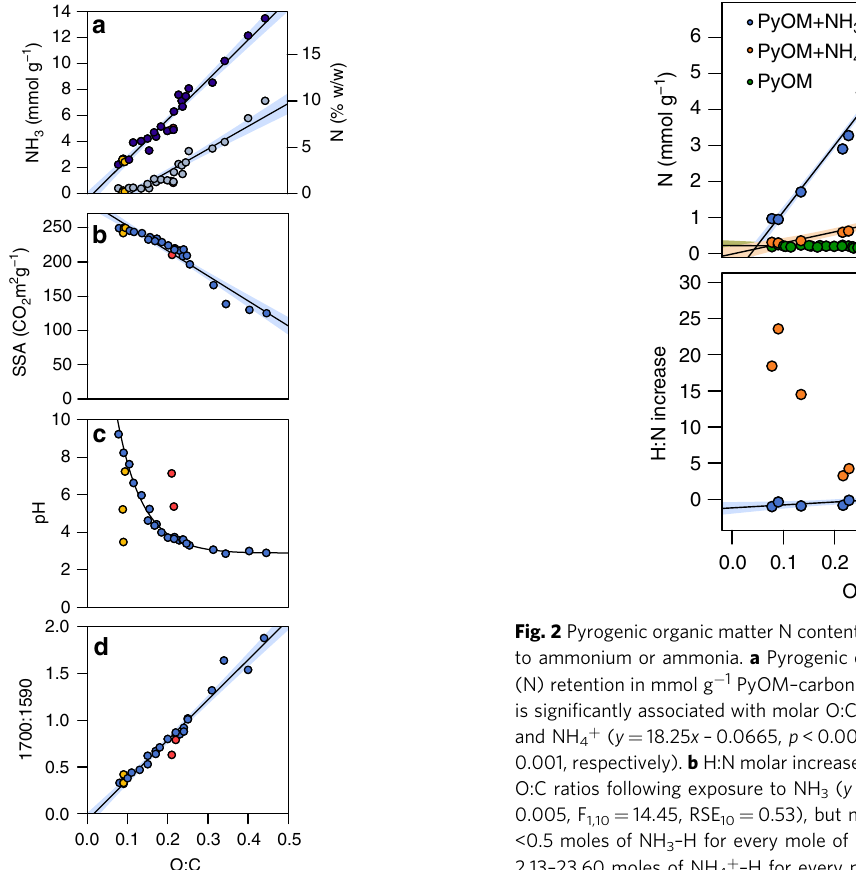
Fig. 1 Changes in pyrogenic organic matter ammonia retention and physiochemical characteristics as a function of molar O:C ratio. a ammonia (NH 3 ) retention capacity — expressed in mmol of NH 3 g − 1 of pyrogenic organic matter-carbon (PyOM – C, left y axis) and percent nitrogen (N) of PyOM – C (right y axis) — increases as a function of molar O:C ratio. Each point represents the average oxygen:carbon (O:C) ratio for two replicates.